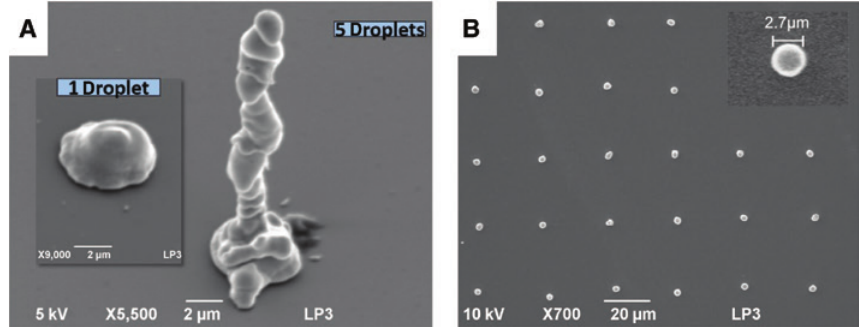
Figure 12: 2D copper structures laser printed with double pulse LIFT